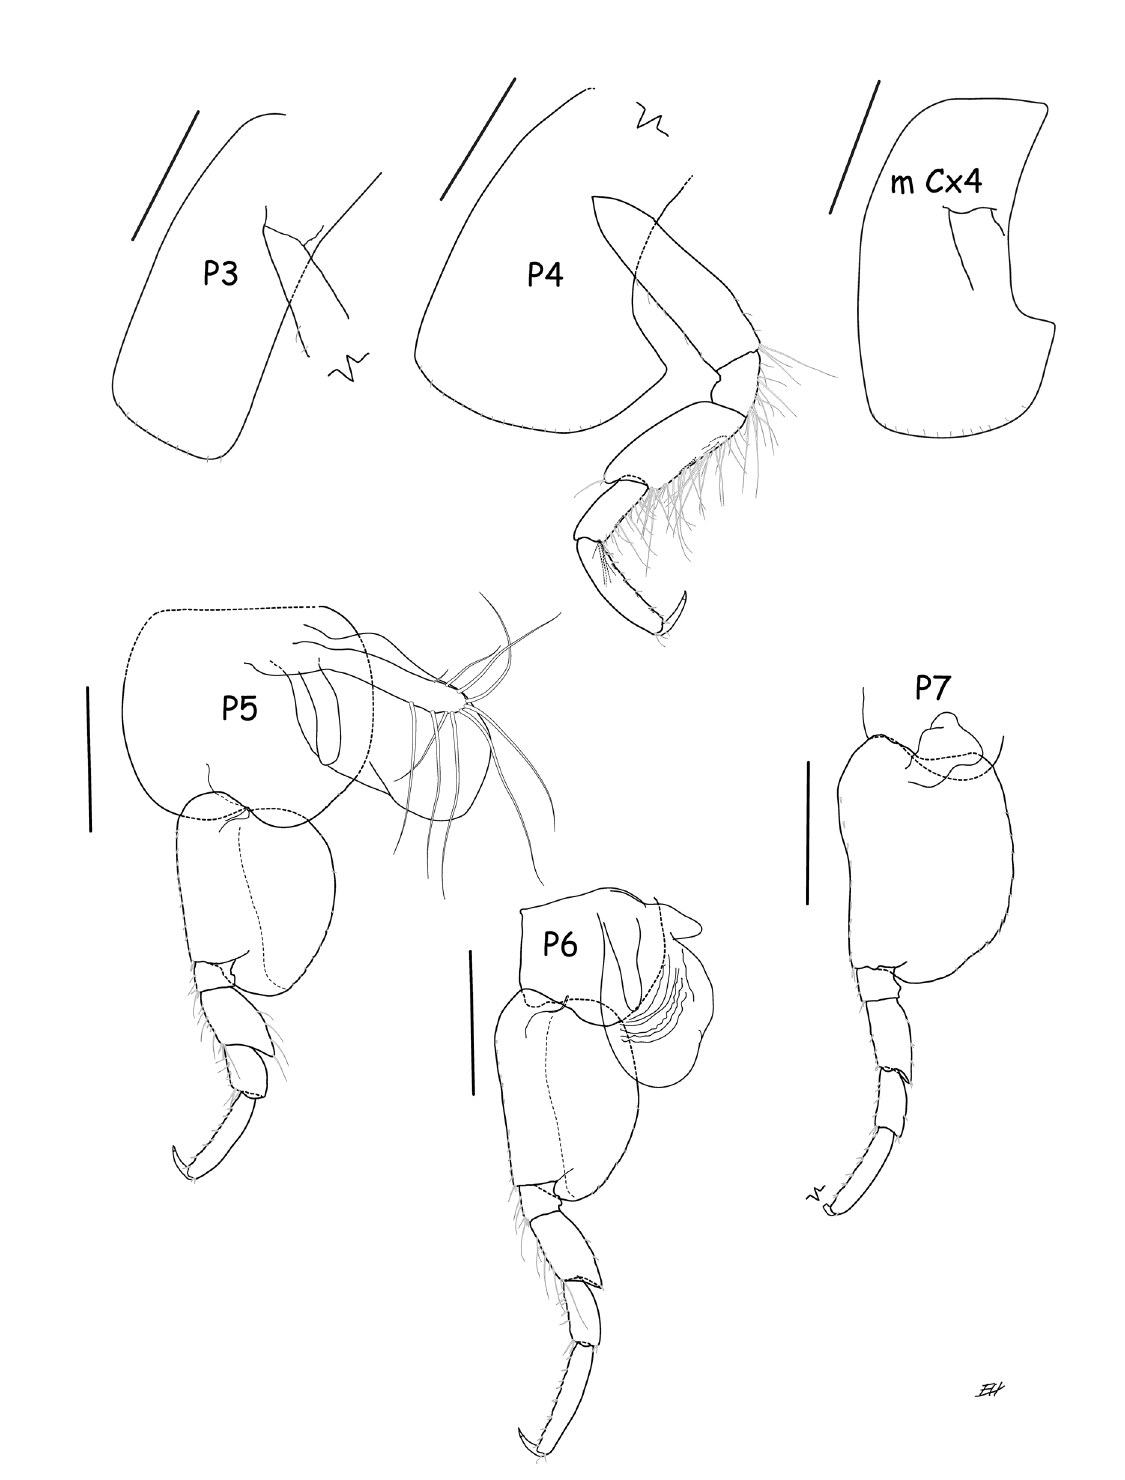
Fig. 24. Abyssorchomene scotianensis (Andres, 1983), ♀, 12 mm (CMNC 2022-0005); ♂, 12.4 mm (CMNC 2022-0007). P3 incomplete, P4 missing brood plate and gill. Figures with sex not indicated are of female. Scale bars = 1